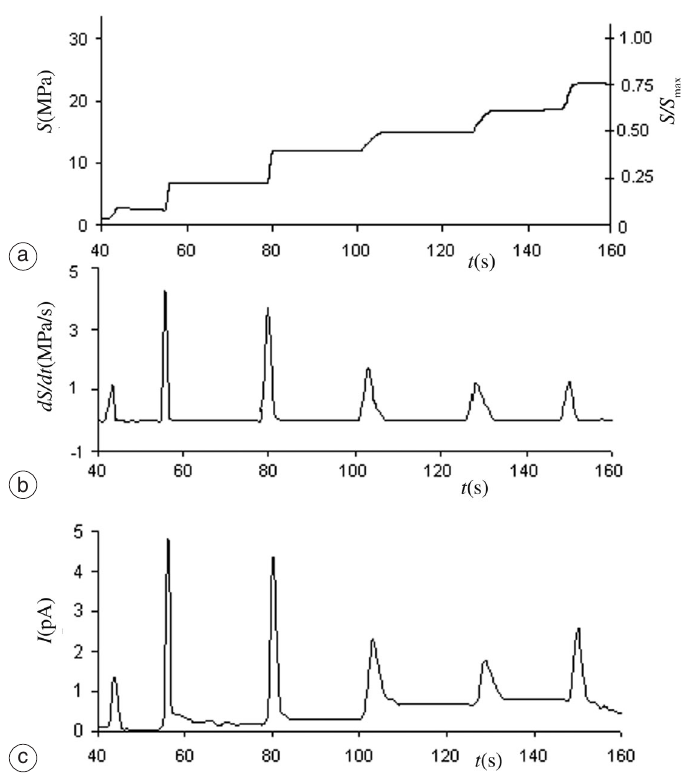
Fig. 3a-c. Time recordings of (a) successive abruptly applied stresses onto the sample (MD007), b) the corre- sponding stress rates and (c) PSC.